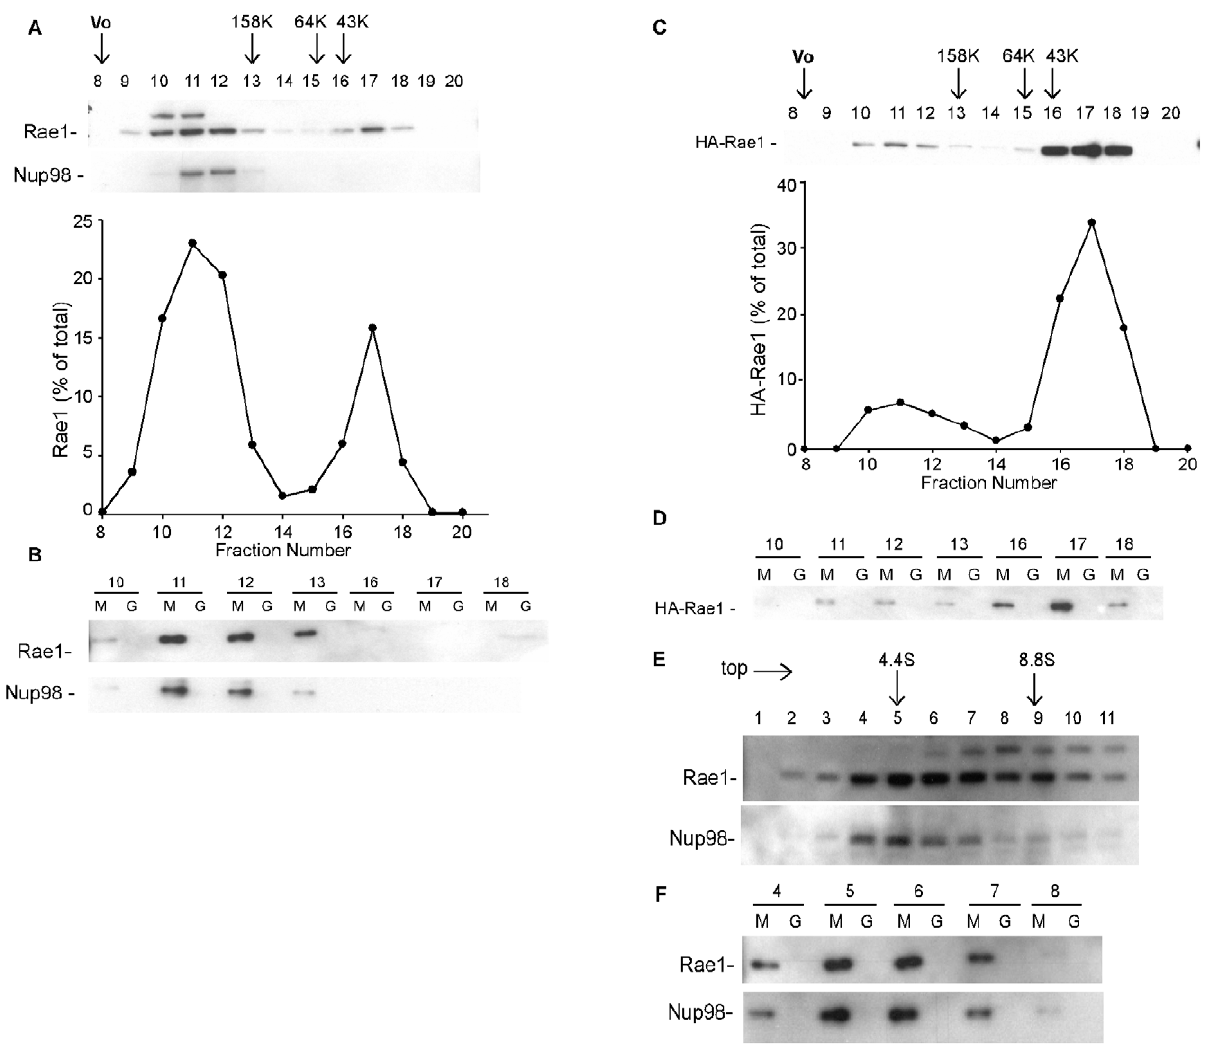
Figure 2. Gel filtration and sedimentation velocity analysis of complexes containing Rae1. ( A ) Cell lysates were chromatographed on a Superdex 200 column. Fractions were analyzed by immunoblots probed for Rae1 and Nup98. Arrows represent the fractions where standards of the indicated molecular weight eluted under the same conditions. The graph represents quantification of % Rae1 in each fraction normalized to total Rae1 eluting in all fractions. Vo indicates the void volume. ( B ) Column fractions from the same experiment as in ( A ) were incubated with wt GST-M protein (M) or GST (G) on glutathione beads for 1 hour. Bound fractions were analyzed by immunoblots probed for Rae1 and Nup98. ( C ) Cells were transfected with plasmid DNA encoding HA-Rae1. Lysates were chromatographed on a Superdex 200 column. Fractions were analyzed by immunoblots probed for HA. ( D ) Column fractions from ( C ) were incubated with wt GST-M protein (M) or GST (G) on glutathione beads for 1 hour. Bound fractions were analyzed by immunoblots probed for HA. ( E ) Cell lysates were subjected to sucrose gradient centrifugation. Fractions were collected from the top and probed for Rae1 (top panel) and Nup98 (bottom panel). Arrows represent fractions containing standards with the indicated s 20,w value subjected to the same conditions. ( F ) Sucrose gradient fractions from ( E ) were incubated with GST-M protein (M) or GST (G) on glutathione beads for 14 hours at 4 u C. Bound fractions were analyzed by immunoblots probed for Rae1 and